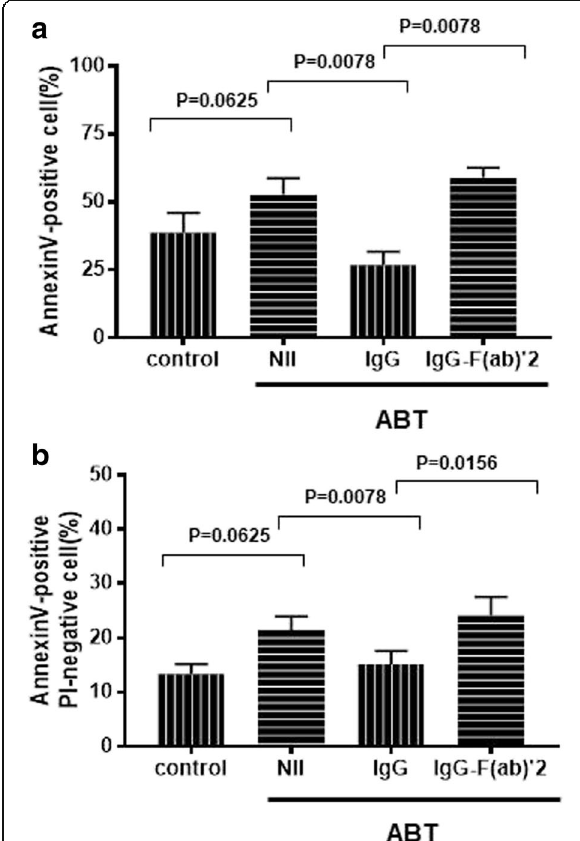
Fig. 2 Differential effects of human IgG and IgG-F(ab ′ ) 2 fragments on the induction of apoptosis of SEB-stimulated monocytes by abatacept. Highly purified monocytes (1 × 10 6 /well) from healthy individuals were cultured in the presence of SEB (100 pg/ml) in each well of 24-well flat- bottomed microtiter plates with abatacept (100 μ g/ml) for 48 h, with or without IgG (100 μ g/ml), or with IgG-F(ab ′ ) 2 fragments (100 μ g/ml). After the cultures, the cells were stained with PE-conjugated annexin V, followed by analysis on flow cytometry. Percentages of total annexin V-positive cells (upper, n = 3) or PI-negative annexin V-positive cells (lower, n = 3) are shown. Error bars indicate SD values of three different experiments. Statistical significance was evaluated by Wilcoxon ’ s signed-rank test. V-positive cells ( a ) and PI-negative annexin V-positive cells ( b